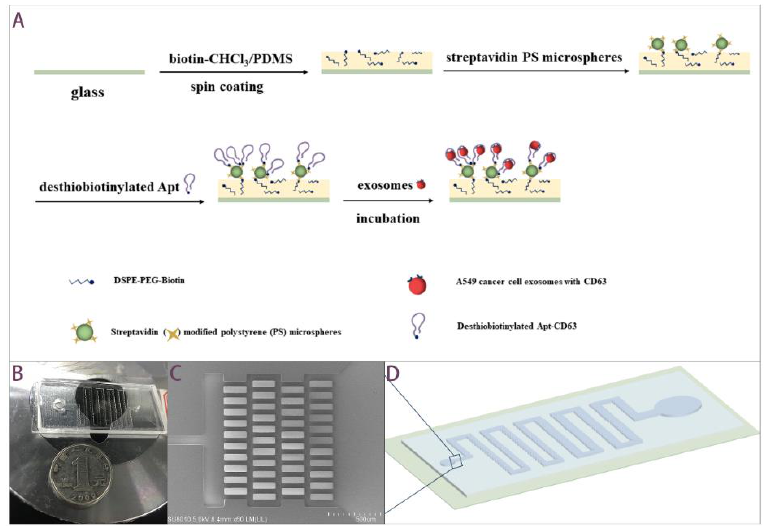
Figure 1. Aptamer-based exosomes isolation microfluidics. ( A ) Immobilization of aptamer onto glass surface for EVs capture. ( B ) Prototype of PDMS/glass chip in comparison with a 1 yuan RMB coin. ( C ) SEM image of micropillars in inlet. The scale bar is 500 μm. ( D ) Schematic diagram of PDMS/glass microfluidics.